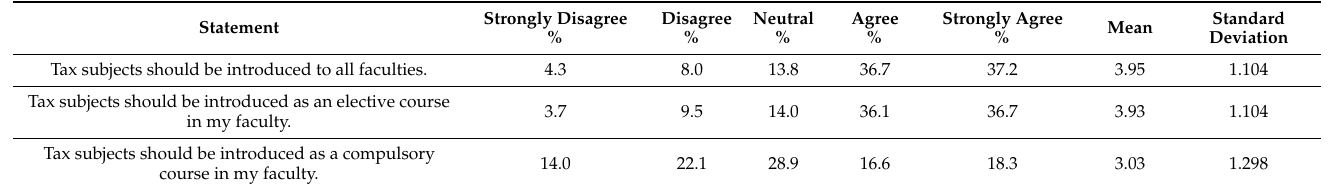
Table 2. Opinion on introducing tax subject into non-accounting